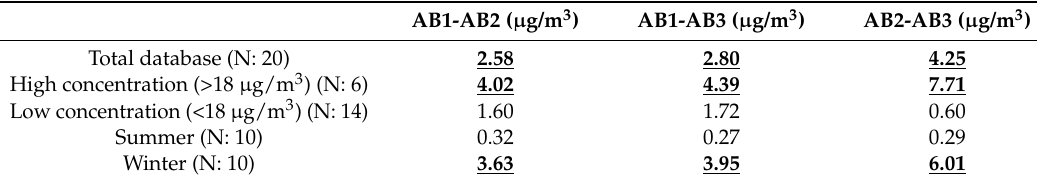
Table 5. Results of uncertainty analysis conducted between couple of co-located instruments.